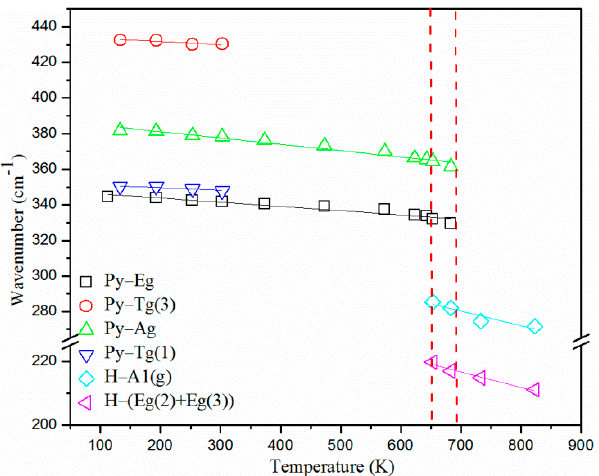
Figure 3. Wavenumber of six peak variations with increasing temperature.